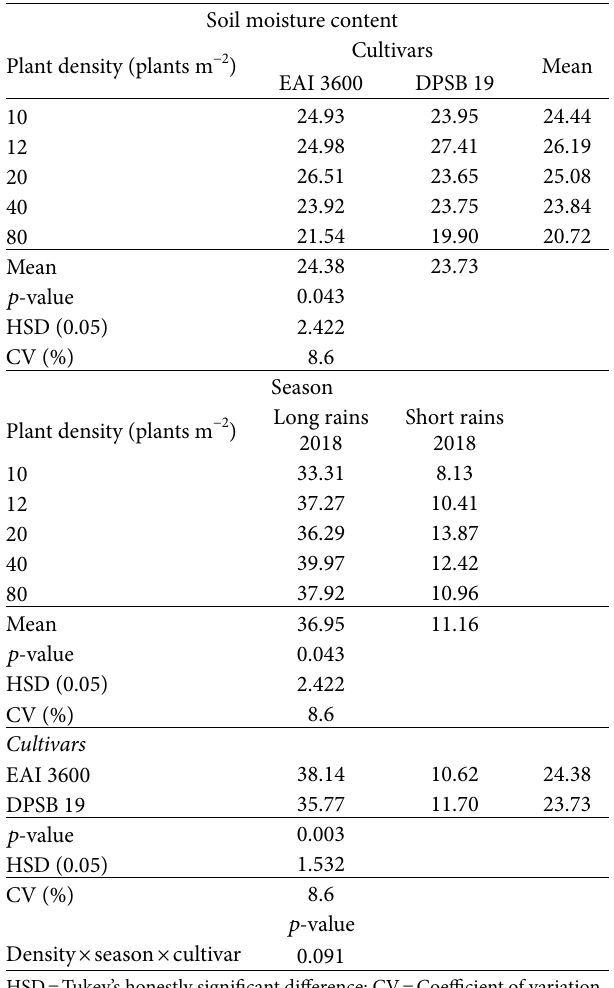
Table 2: Effect of plant density and cultivar on soil moisture con- tent (% v/v) at 50% flowering stage.